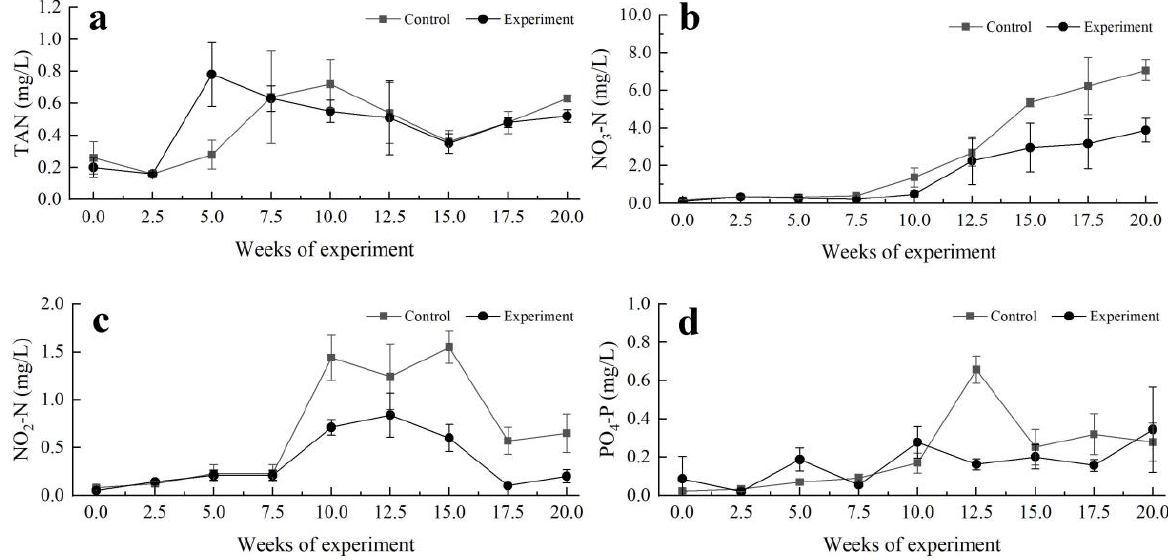
Figure 2. Changes of water quality parameters in the control and treatment group during the experiment. ( a ) TAN; ( b ) NO3-N; ( c ) NO2-N; ( d ) PO4-P. Vertical bars represent the mean ± SD ( n = 3).